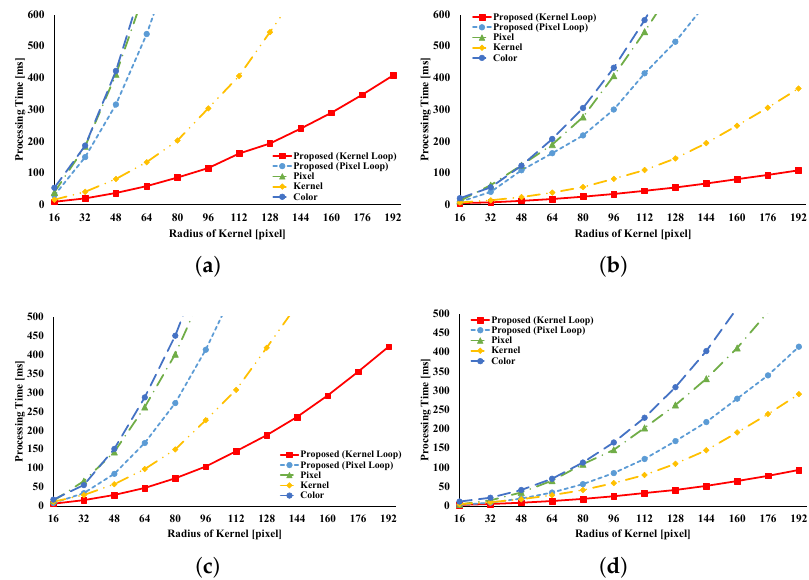
Figure 18. Processing time for randomly-kernel-subsampled adaptive Gaussian filtering (RKS-AGF) with respect to the kernel radius of FIR filtering. ( a ) 1/4 subsample in weight computation; ( b ) 1/16 subsample in weight computation; ( c ) 1/4 subsample in LUT; ( d ) 1/16 subsample in LUT. Arbitrary pixel loop unrolling and arbitrary kernel loop unrolling are used in place of pixel loop unrolling and kernel loop unrolling, respectively.